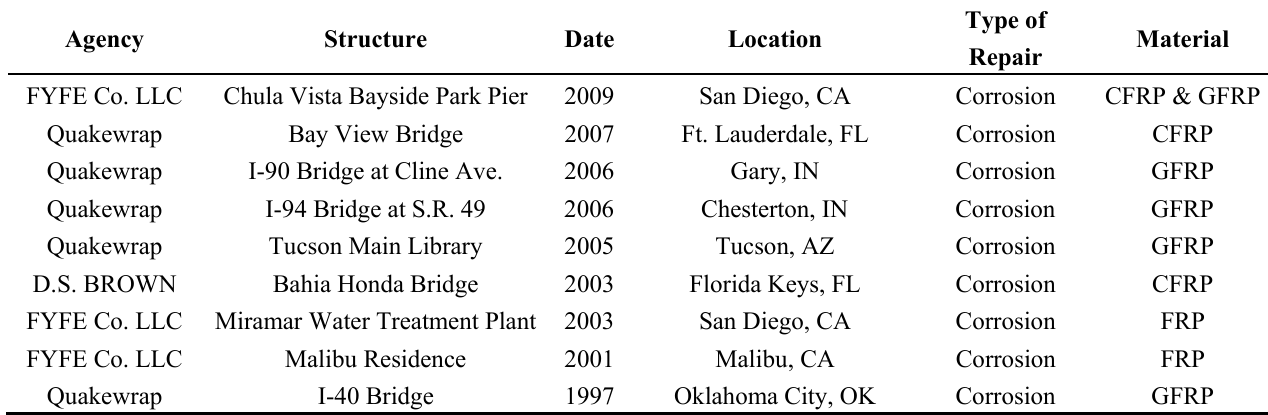
Table 4. Selected field application projects: columns retrofitted for corrosion. Agency